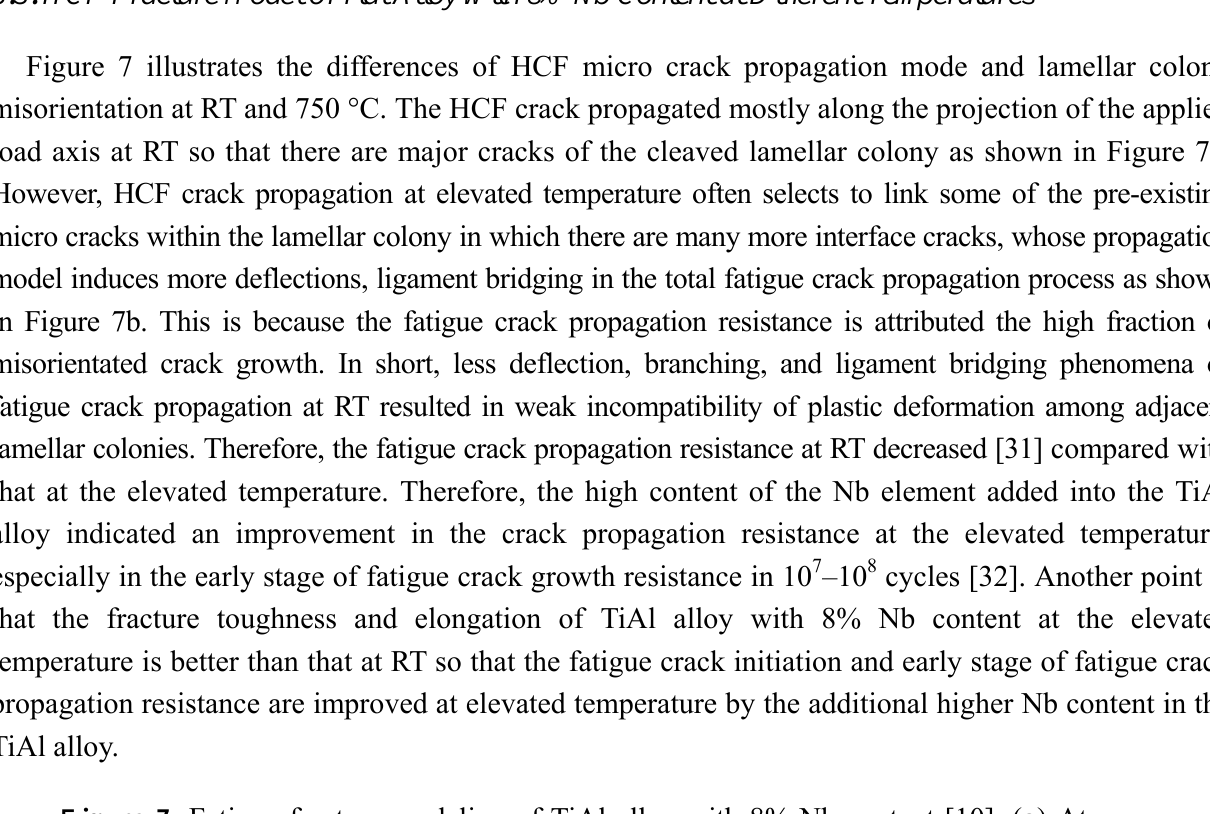
Figure 7. Fatigue fracture modeling of TiAl alloy with 8% Nb content [10]. ( a ) At room temperature; ( b ) At elevated